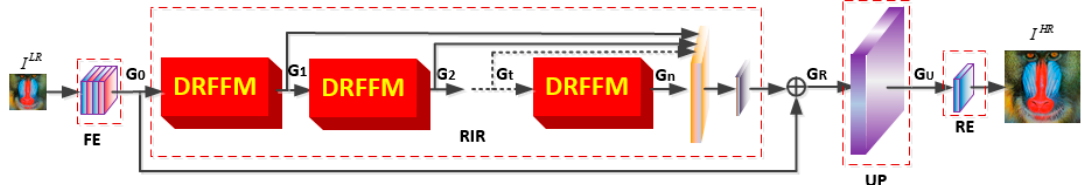
Figure 2. The overall architecture of DRFFN. The red dotted rectangle represents the trunk part of the network, which consists of the four parts of FE, recursive-in-recursive (RIR), UPAND RE, and the detailed description is provided in Section 3.2. The deeply recursive frequency fusing module (DRFFM) is the primary unit of the network.